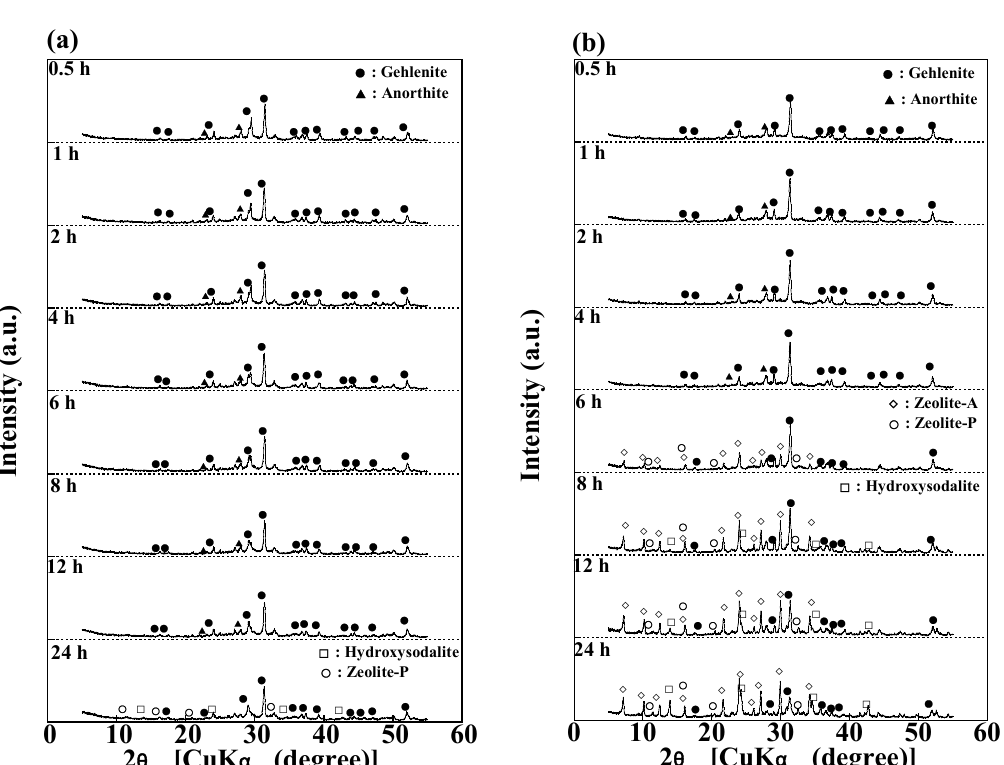
Figure 7. SEM photos of the synthesized products: ( a ) 80 °C without 1 M EDTA, ( b ) 120 °C without 1 M EDTA, ( c ) 160 °C without 1 M EDTA, ( d ) 80 °C with 1 M EDTA, ( e ) 120 °C with 1 M EDTA, and ( f ) 160 °C with 1 M EDTA (NaOH concen- tration: 3 M NaOH, Reaction time: 24 h).